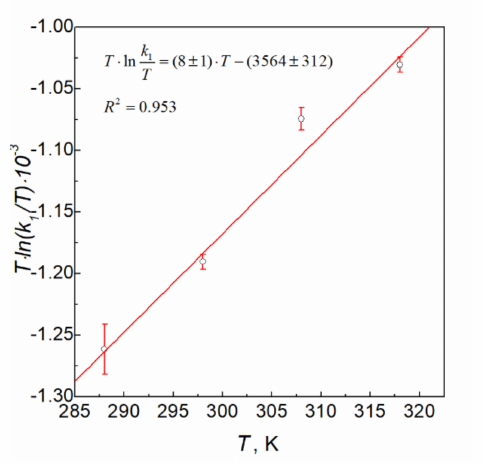
Figure 4. The linear plot of Eyring dependence ( T · ln( k 1 / T ) vs. T ) for the reaction between platinum(IV) chloride complex ions and sodium borohydride in aqueous solution. Conditions: C 0,Pt(IV) = 0.05 mM, C 0,NaBH4 = 3.0 mM, pH = 12.9 ±